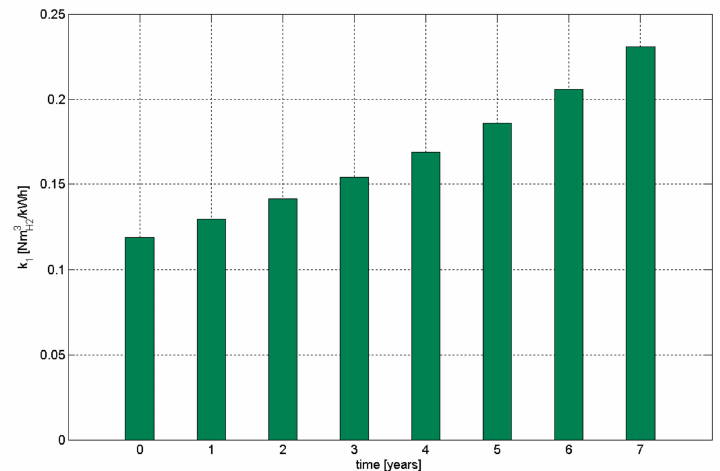
Figure 9. Change in the value of decision criterion k 1 for the S-I scenario.